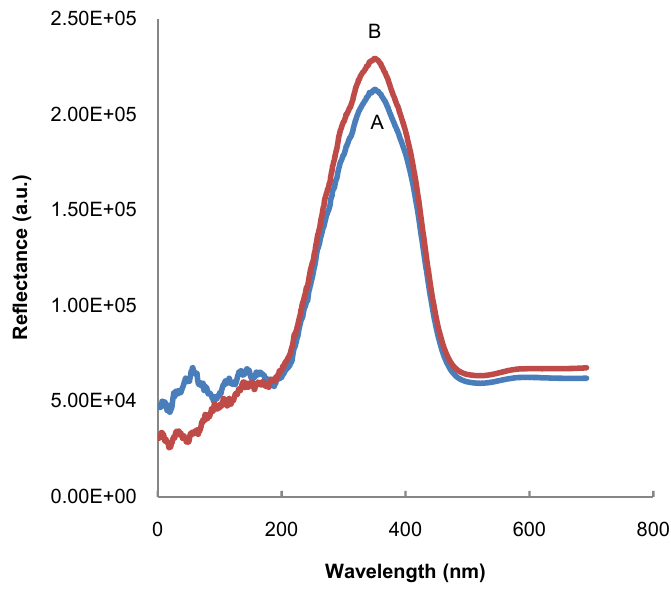
Figure 1. Reflectance spectra for test strips (A) before and (B) after being introduced into 100 ppm of benzoic acid